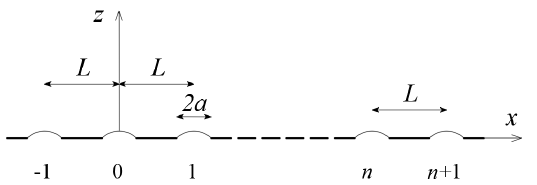
Figure 4. A surface with an array of membranes oscillating at the first eigenfrequency.